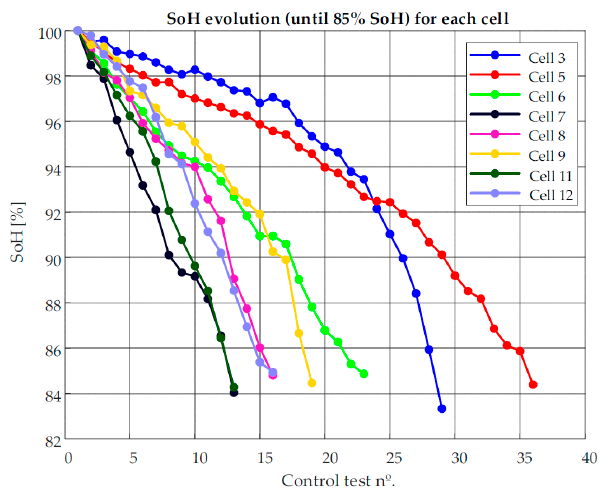
Figure 4. SoH evolution for each cell.